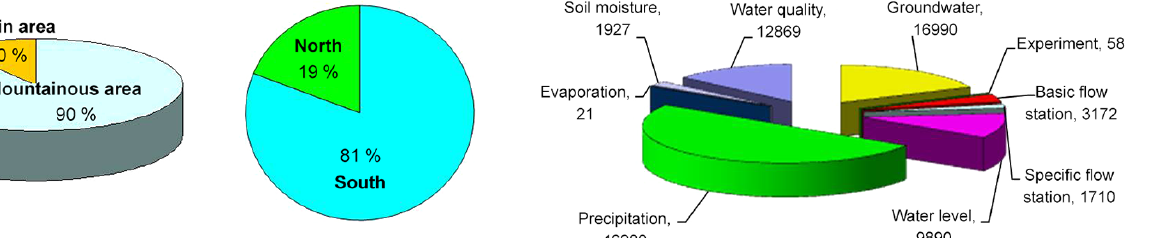
Figure 2. Structure of hydrological stations in